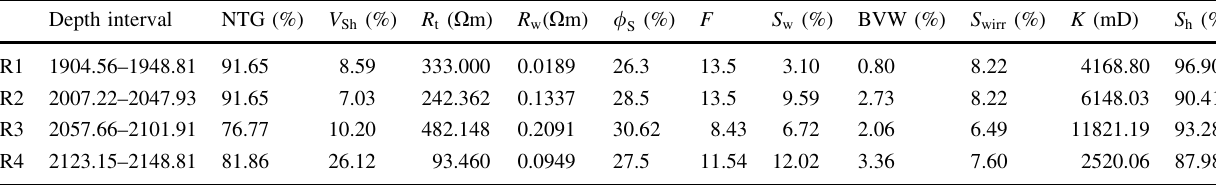
Table 1 Estimated petrophysical parameters at well 0111 Depth